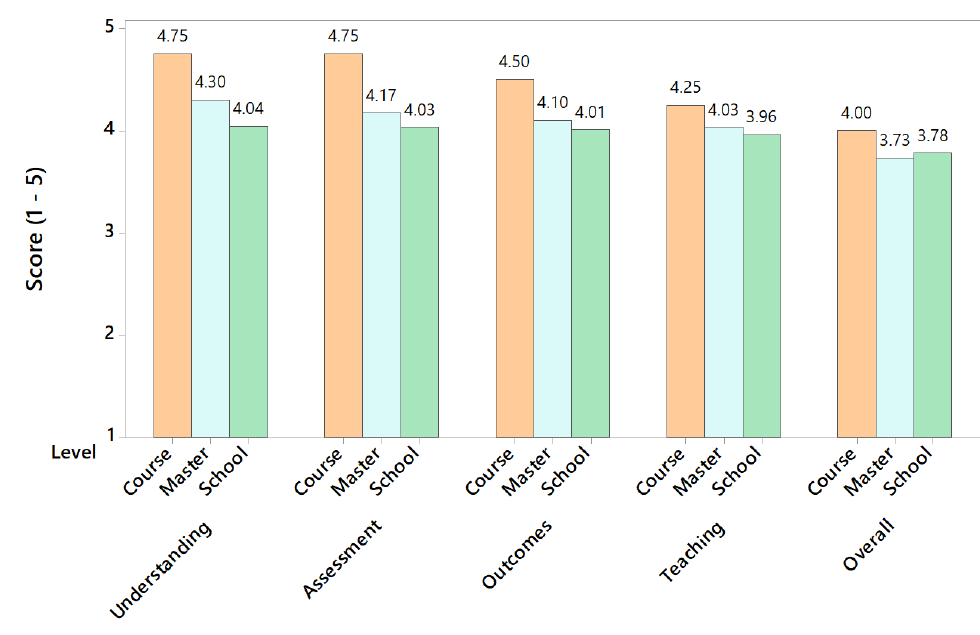
Figure 5. Scores assigned by students to a master course including the game